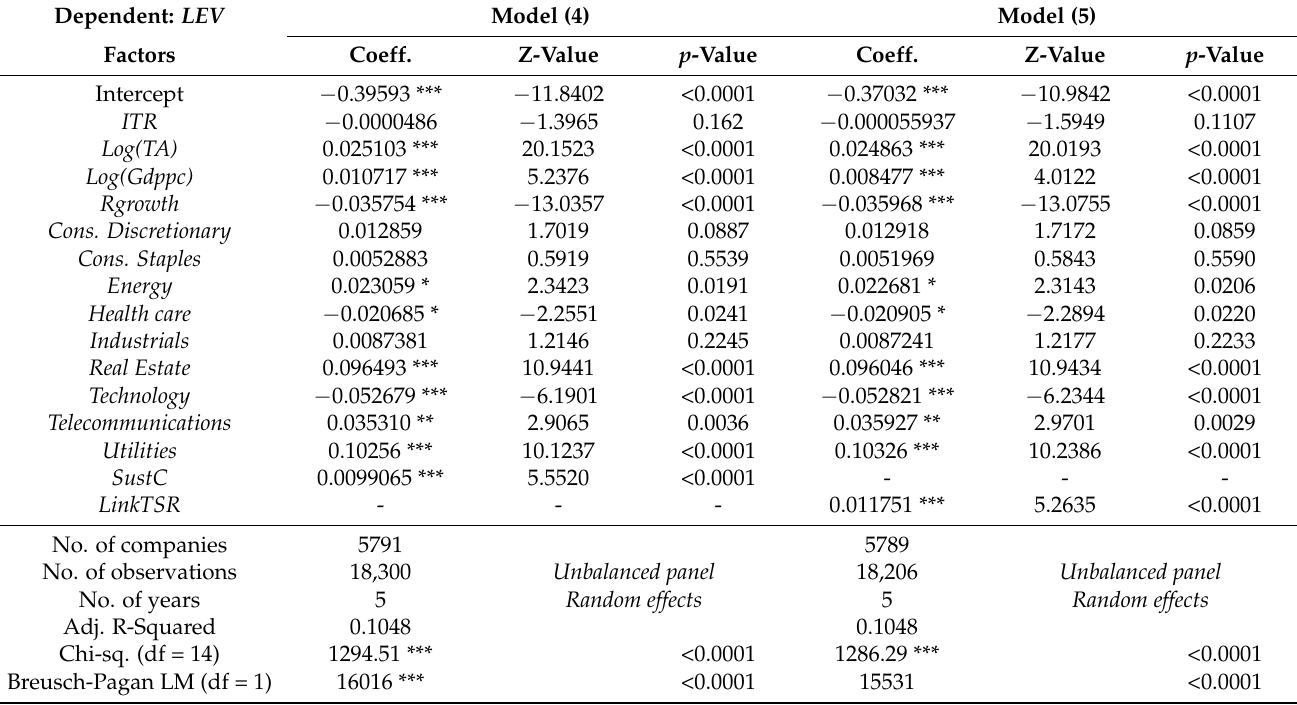
Table 9. Panel regression results for leverage ( LEV) as the dependent variable in models (4) and